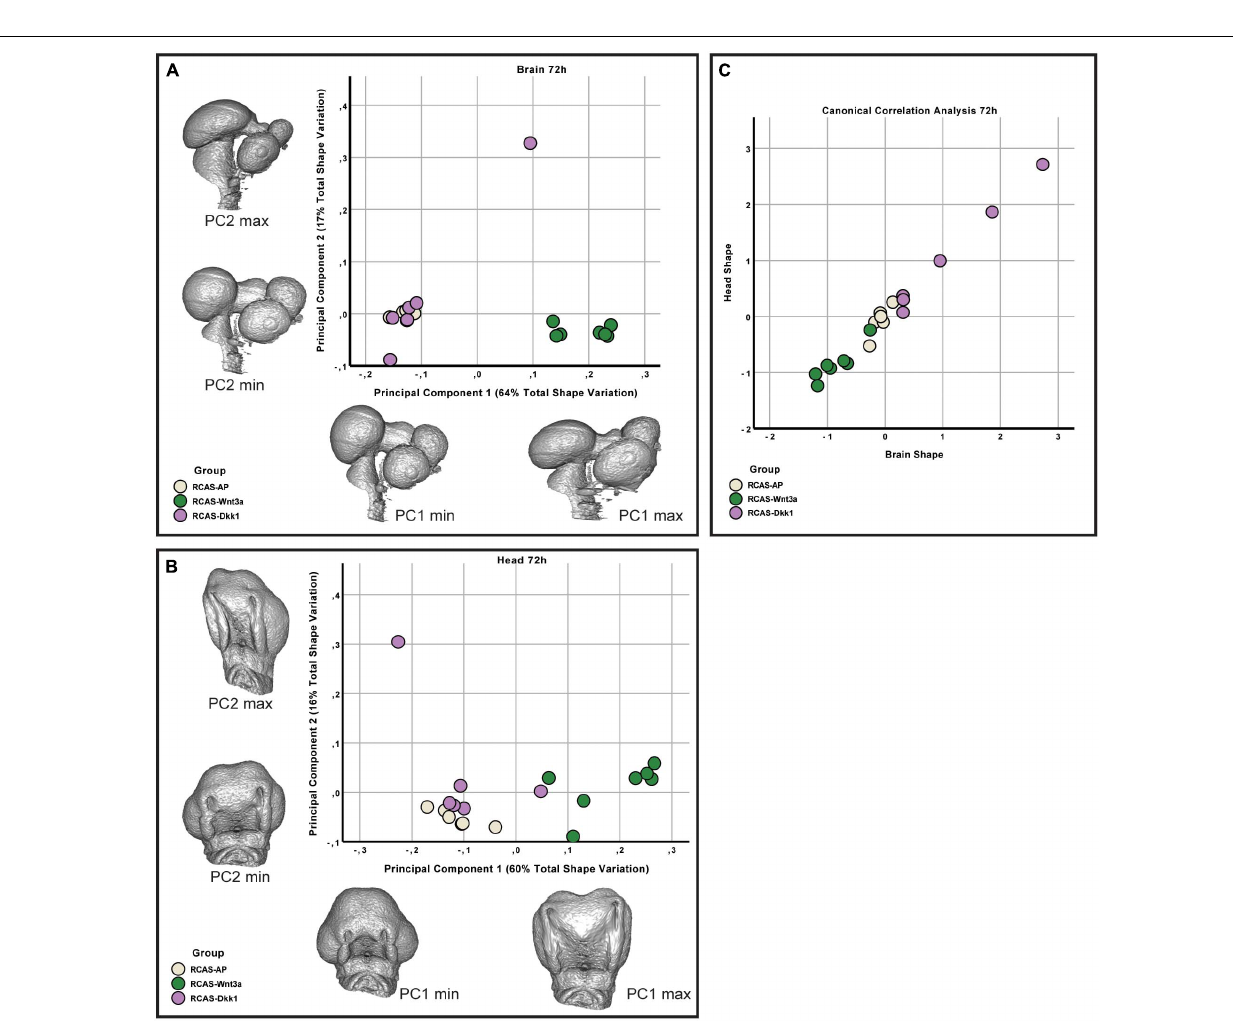
Frontiers in Cell and Developmental Biology |